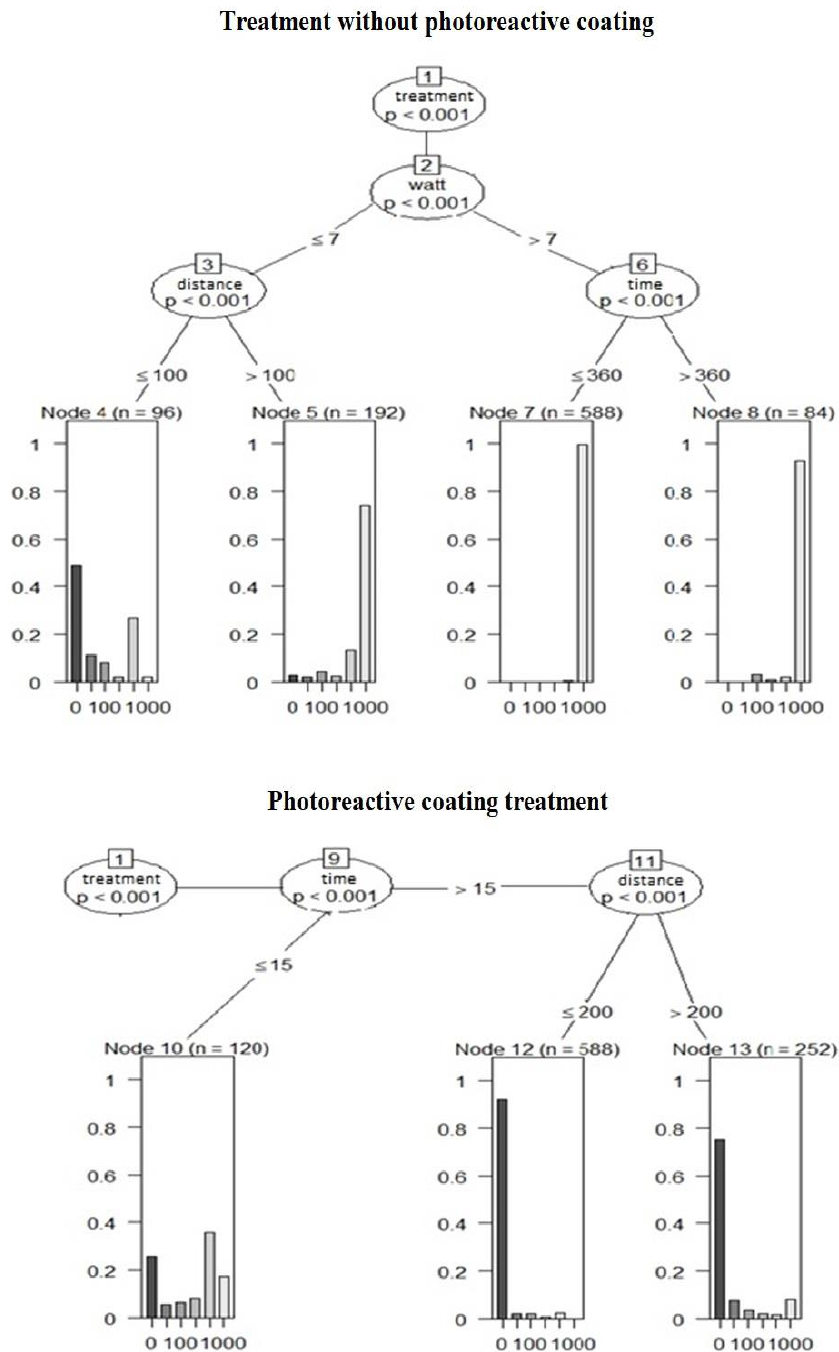
Figure 4. Comparison of control and treated surfaces by random forest method as a function of light intensity and illumination distance. When examining luminance and distance, the p -value of all variables was less than 0.001 at the first branching, but overall, the effects of wattage, distance, and time were more moderate on the model hit rate compared to the treatment.